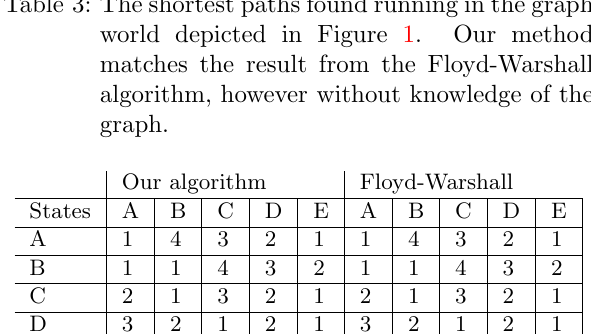
Table 3: The shortest paths found running in the graph world depicted in Figure 1. Our method